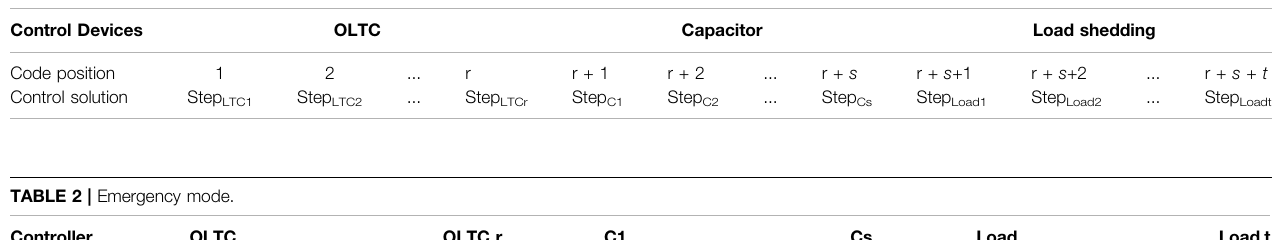
TABLE 1 | Encoding of a control solution.